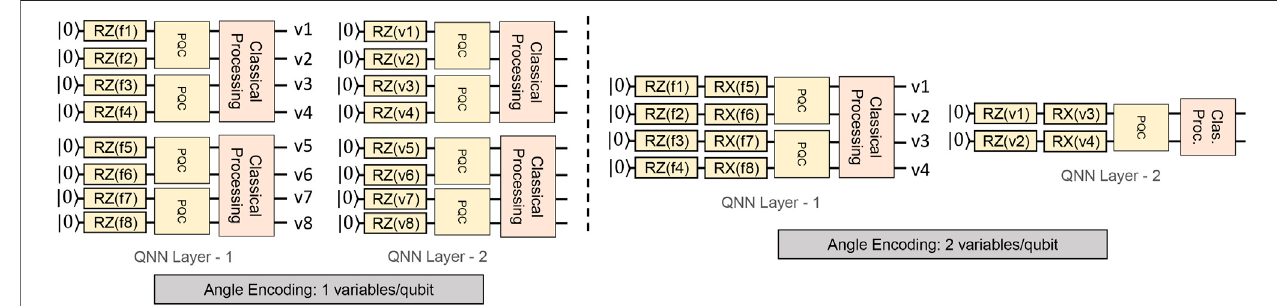
FIGURE11| Throughoutthiswork,wehaveused1-variable/qubitangleencodingforalltheQNNmodels.Allthesenetworks(QNet,Baseline,PCA+Baseline)can bene fi t from improved classical-to-quantum data encoding methods. Here, we show the impact of using the 2-variables/qubit angle encoding method on the QNet networkfor an 8-feature ML problem. We use QQ (cid:2) 2, PL (cid:2) 2, QL (cid:2) 2. While the fi rstnetworkuses a total of82-qubitcircuits, the second one uses only 3. However, we may potentially lose information while loading too many variables in a single qubit, and that may affect the performance/trainability of these models [8]. We keep exploration on this front for future